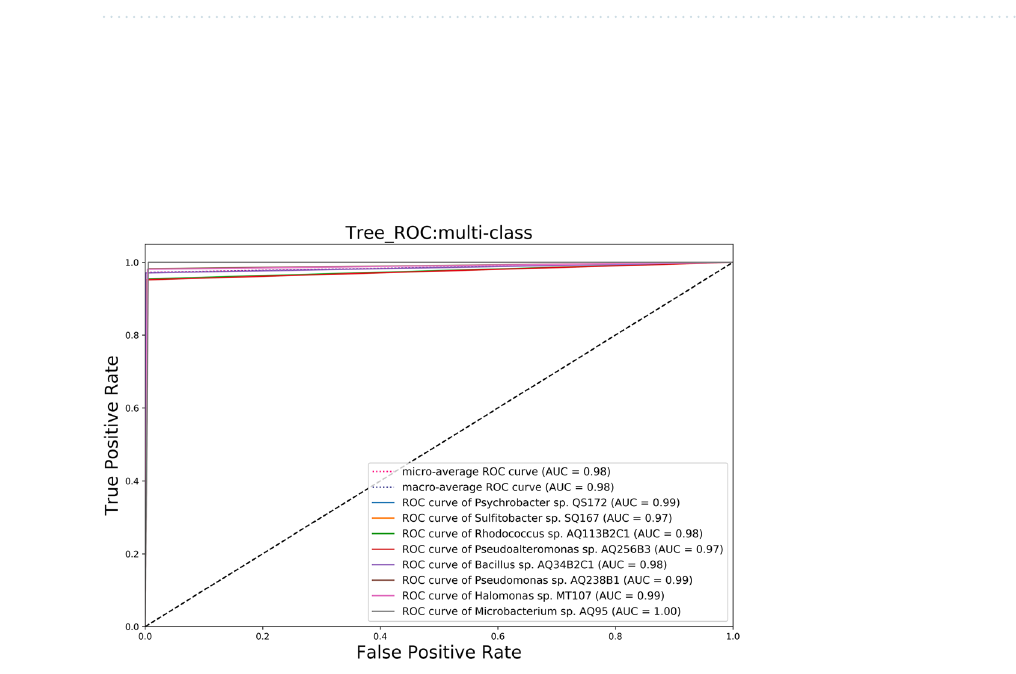
Figure 4. Confusion matrix of 8 cold seep bacteria. All spectra of each bacterium are classified into the correct category.